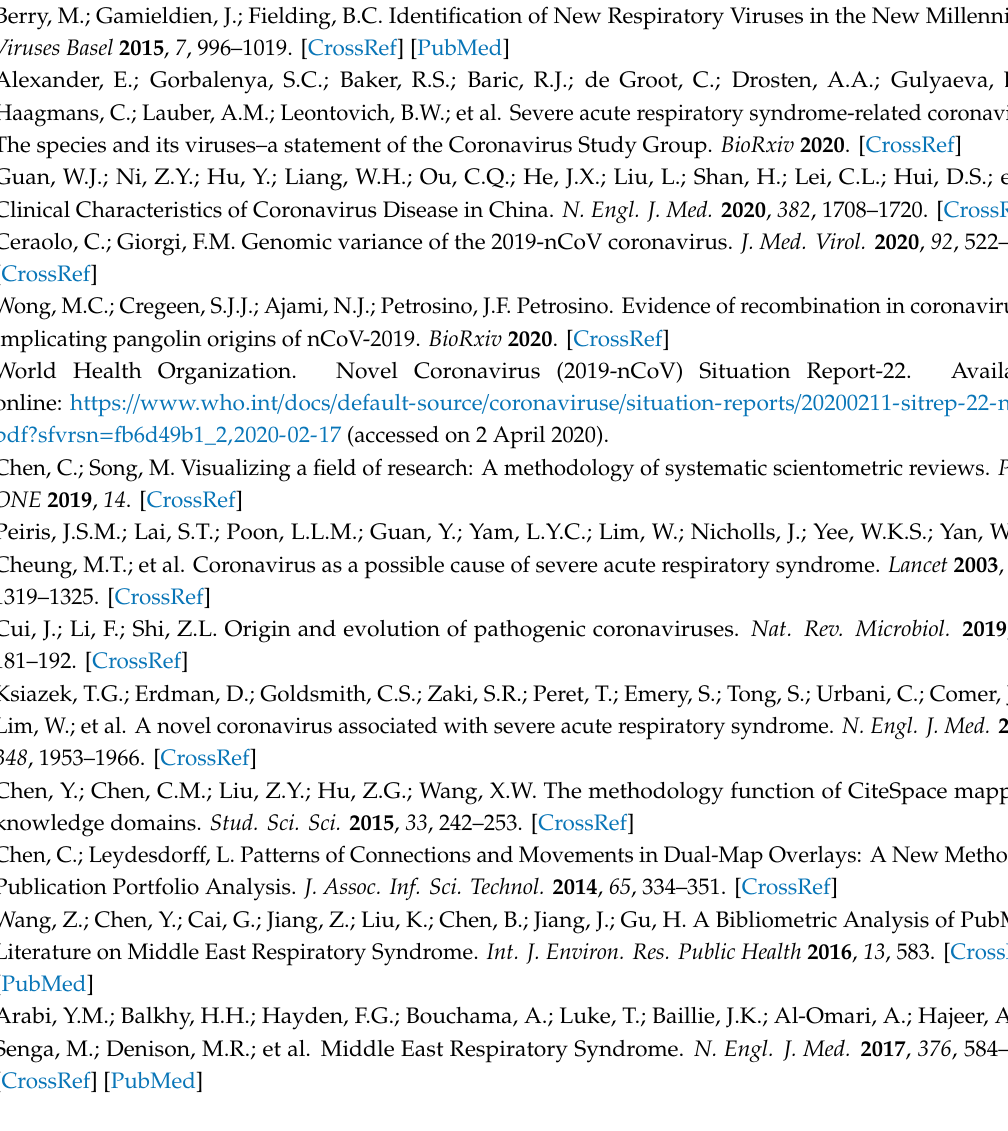
Figure S1: The trend of annual publications on the research of coronavirus during 1969–2020, Figure S2: Co-occurring subject category network, Figure S3: Partial co-authorship network of organizations, Figure S4: Top 20 keywords with the strongest burst strength, Table S1: Top 20 journals in the field of coronavirus, Table S2: Proportion of documents published by international